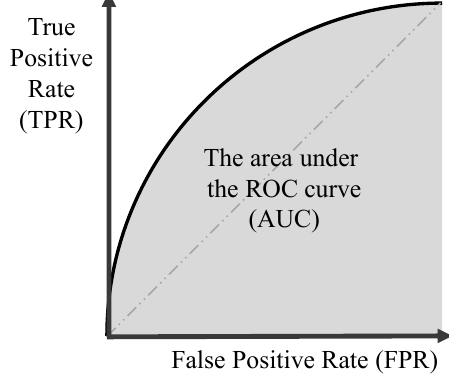
Figure 14. Receiver operating characteristic